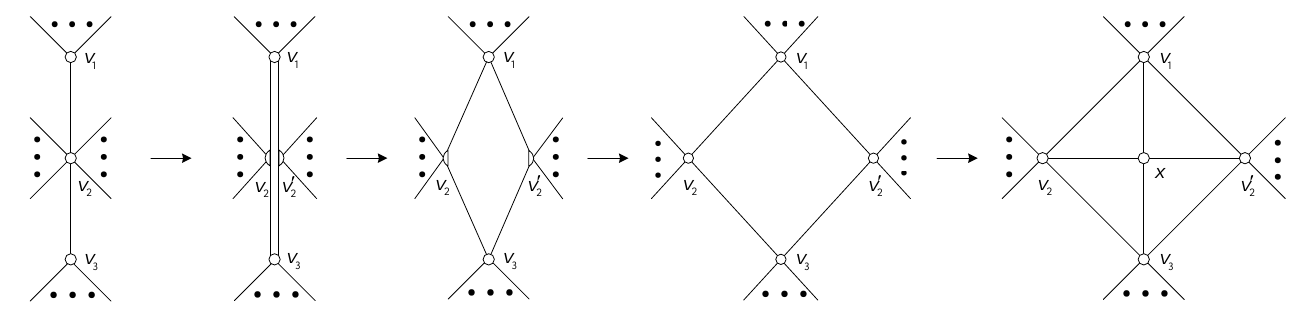
Figure 2. The extending 4-wheel operation.